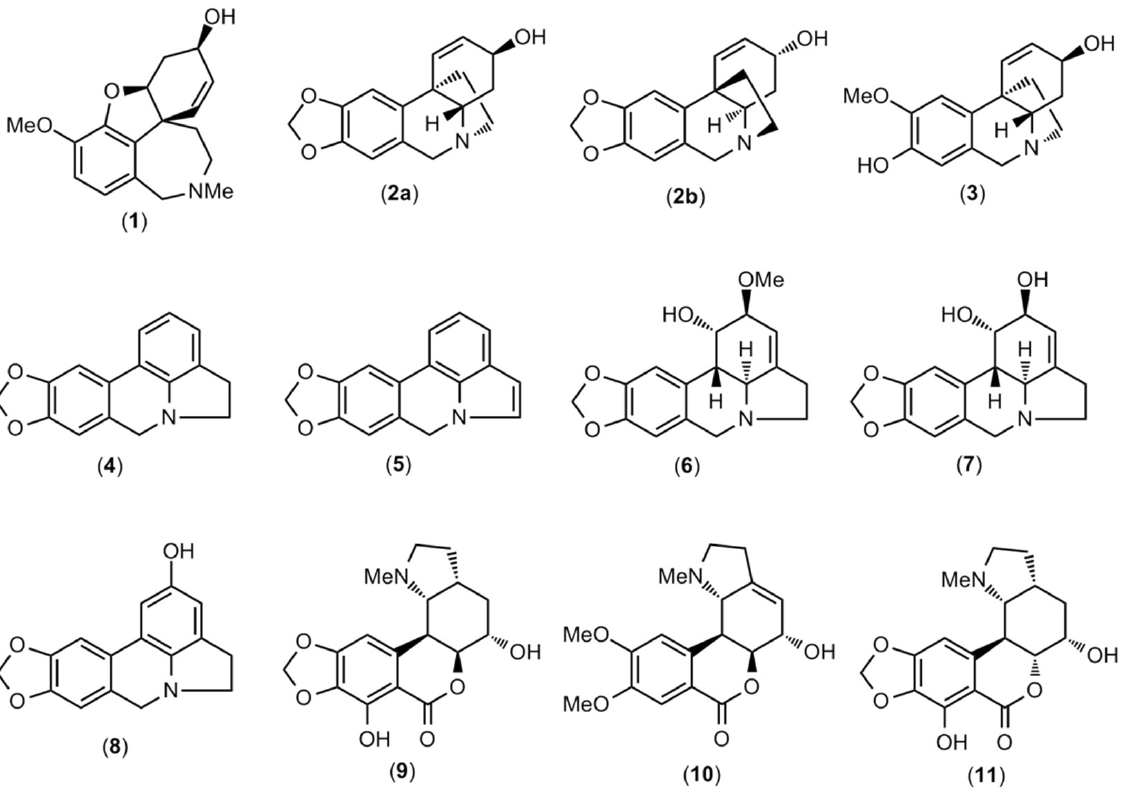
Figure 1. Structures of alkaloids identified by GC-MS in Clinanthus milagroanthus collected in Peru.